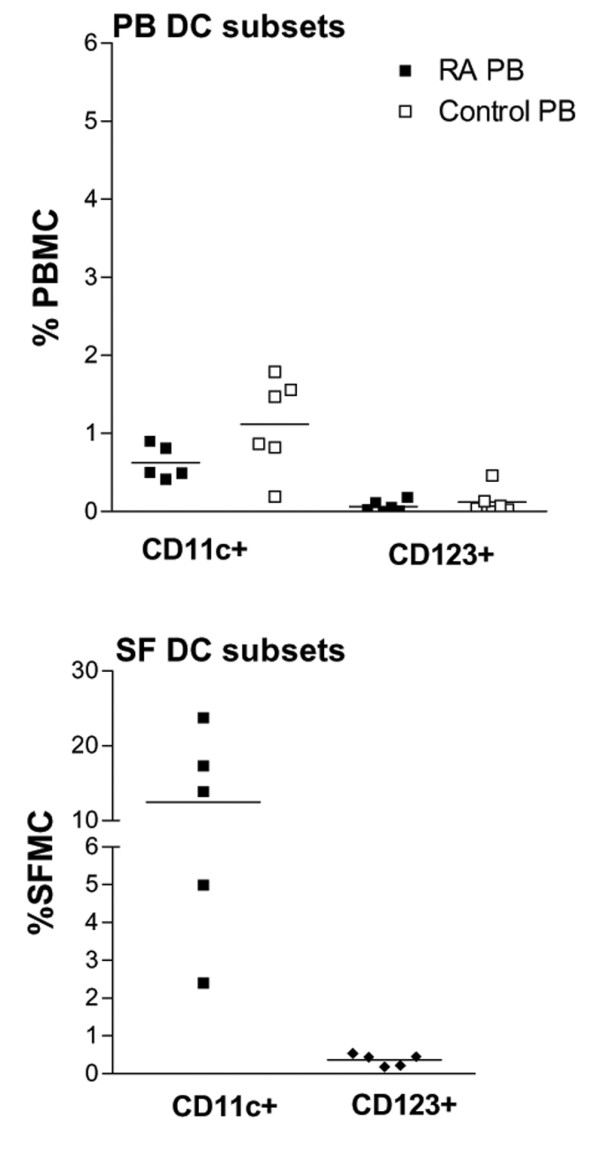
CD11c+ dendritic cells (DCs) and CD123+ DCs are present in rheumatoid arthritis (RA) synovial fluid (SF). After purification of mononuclear cells from either normal or RA peripheral blood (PB) or RA SF, cells were stained with CD123-PE, CD11c FITC, CD14-PECy5, and HLA-DR-APC. Live HLA-DR+CD14- mononuclear cells were gated; polymorphonuclear cells were excluded on the basis of forward and side light-scatter. Scatter plots depict percentage of total PB or SF cells expressing the indicated markers for all donors. APC, antigen-presenting cell; PBMC, peripheral blood mononuclear cells; PE, phycoerythrin; SFMC, synovial fluid mononuclear cells.